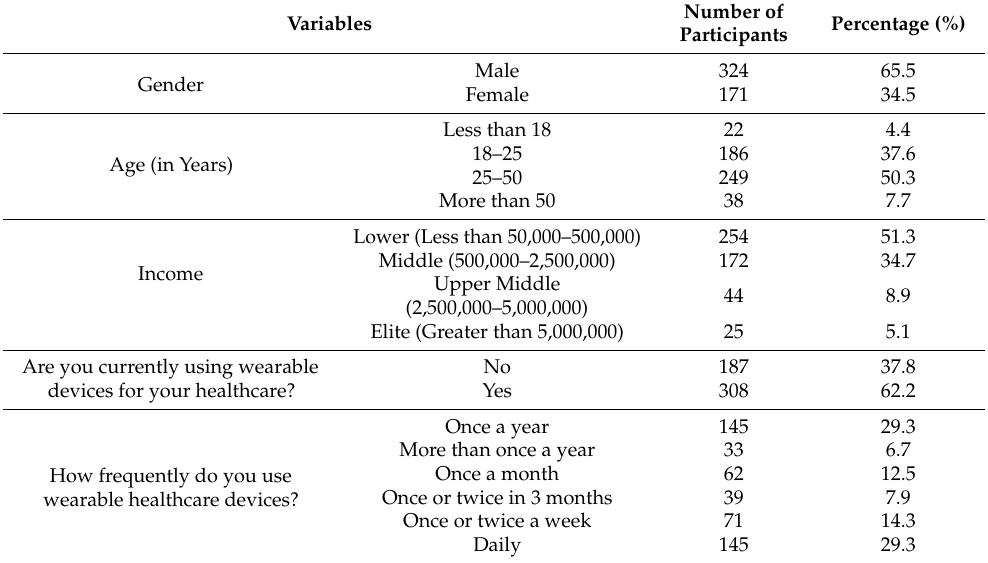
Table 1. Demographic characteristics of study participants.